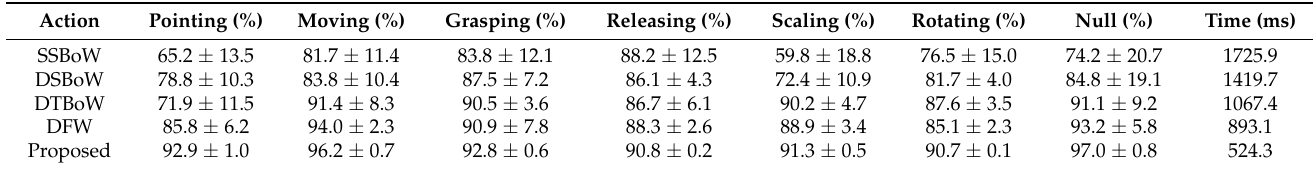
Table 5. The recognition accuracy and processing time on Assembly Gesture Video Dataset with other algorithms.